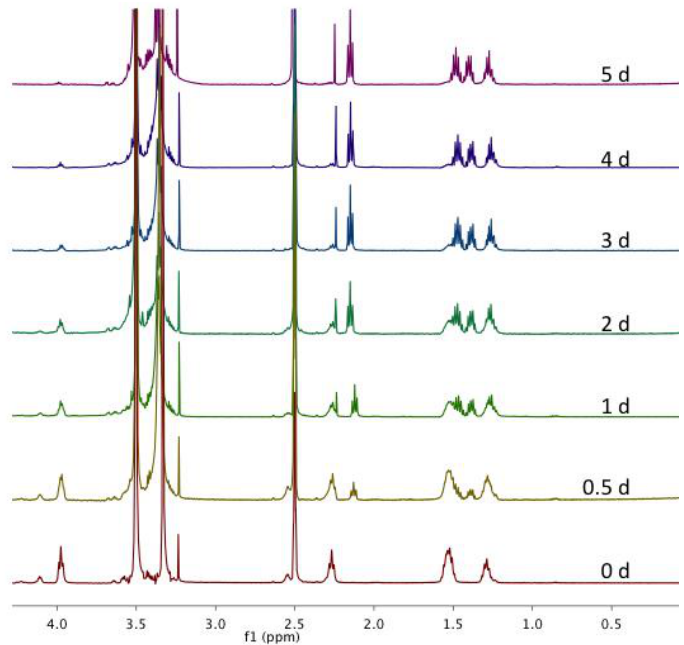
Figure A10 . Overlay of magnified 1 H NMR spectra in DMSO-d 6 of CMS nanocarriers after incubation with Novozyme ® 435 at 32 °C at various time points during a five-day study.